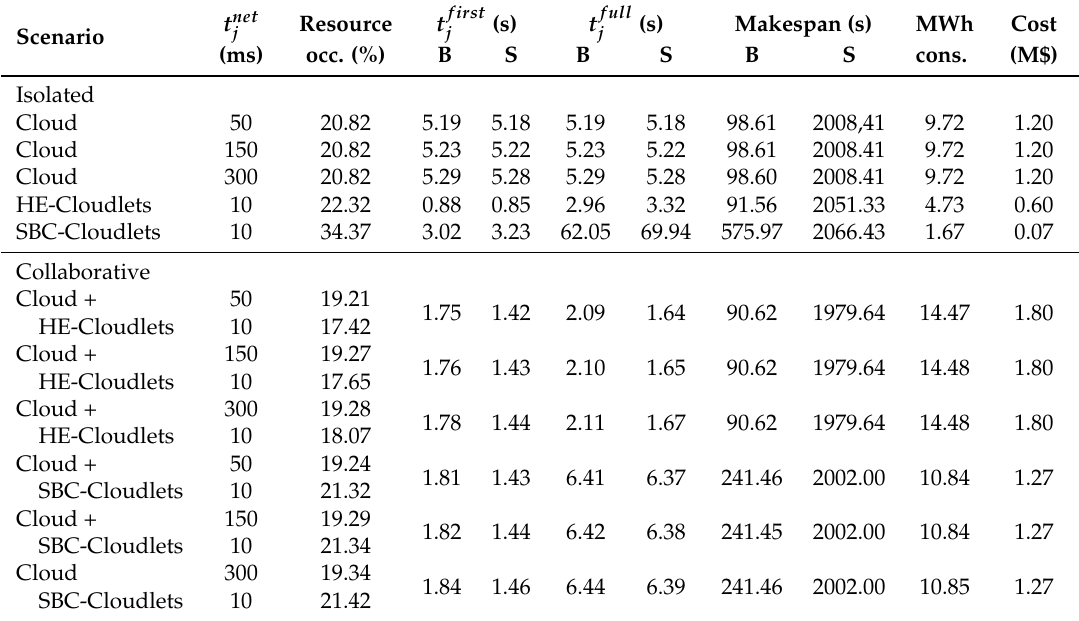
Table 6. Performance, energy consumption and costs results for each scenario for compute-intensive workloads. t net represents the network delay, while t first and t full represent the time a job spends in j j j queue until its first task and its last task is scheduled, respectively. B means batch jobs while S means service jobs. To compute acquisition costs, we took average Dell PowerEdge R640 server and Raspberry Pi 3 prices, 2500 and 35 dollars,